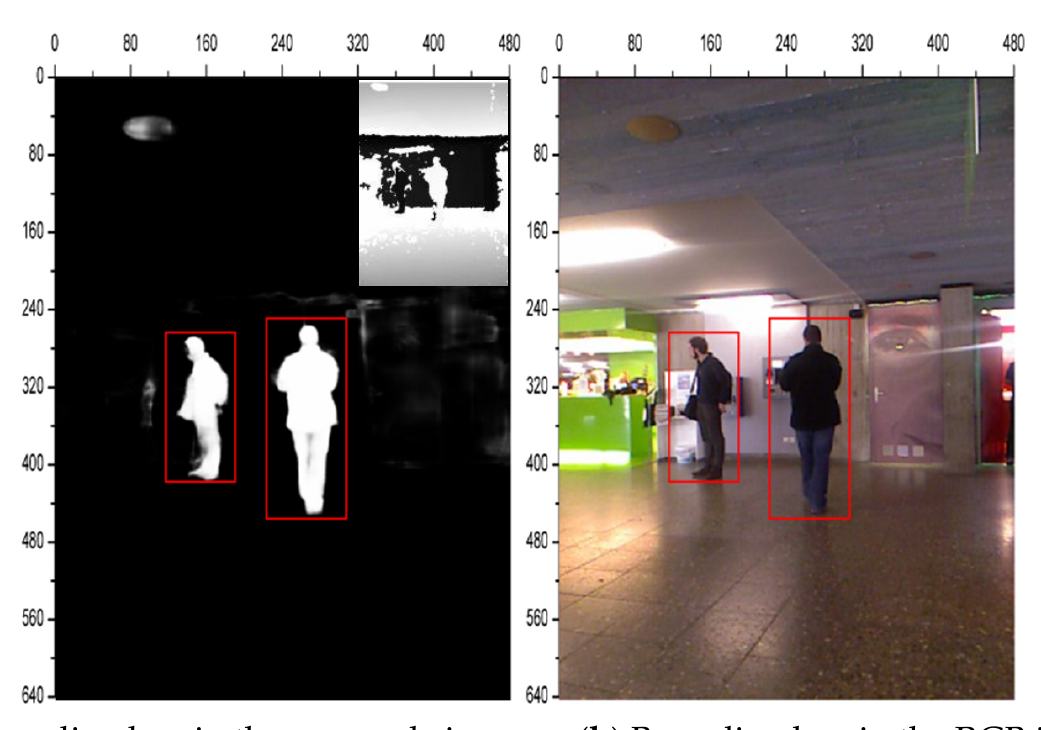
Figure 8. We project the semantic information with bounding boxes in the grayscale image into the color image under the same coordinates. color image under the same